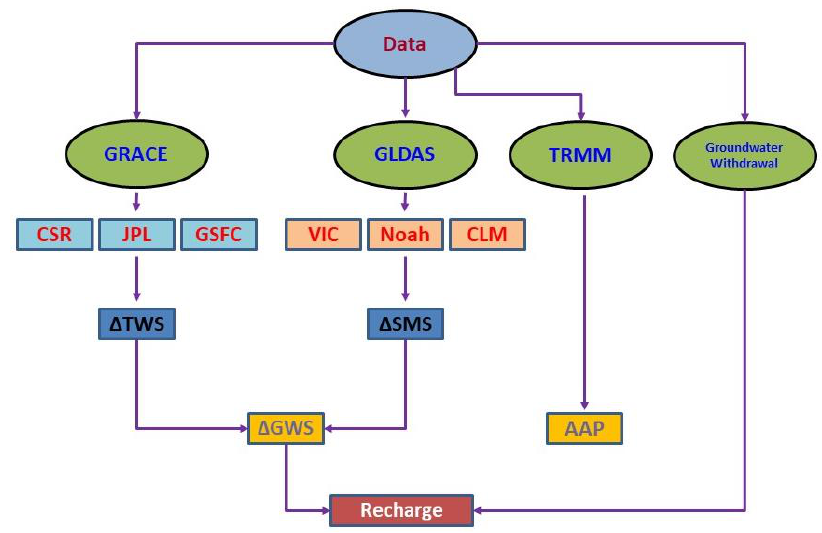
Figure 2. The methodological framework of the study.